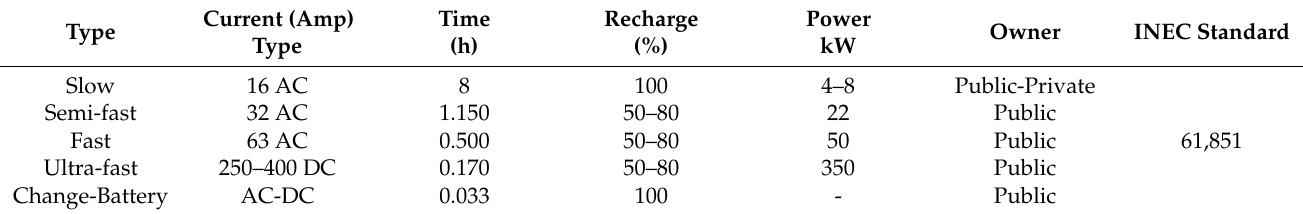
Table 3. Types of charging terminals for ICSEC